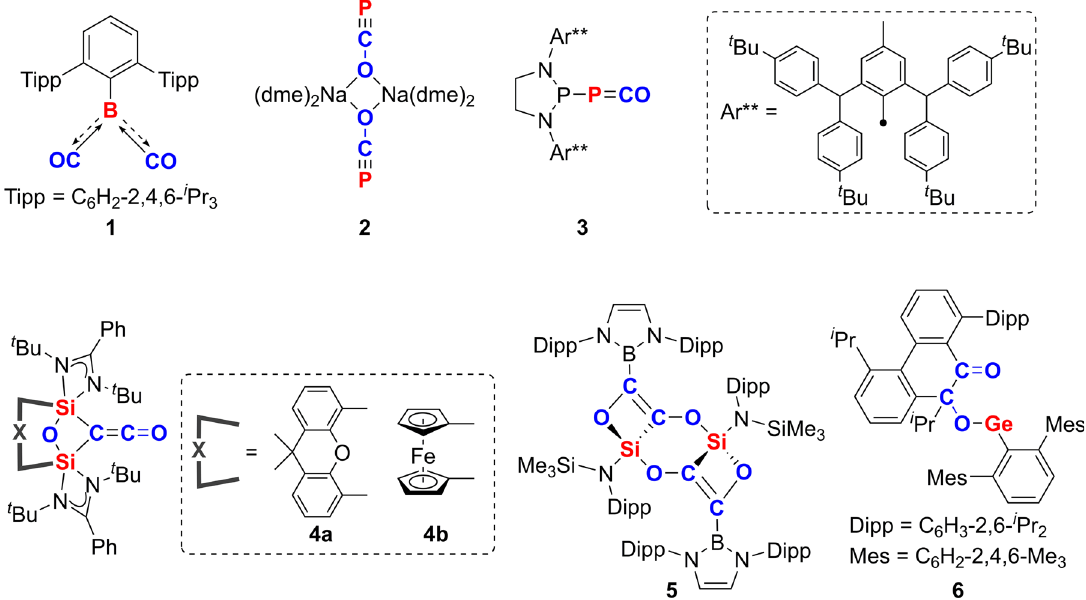
Fig. 1 Selected examples of main-group element compounds formed in the reactions with CO. Boron dicarbonyl complex ( 1 ) 5 , sodium phosphacyanate ( 2 ) 7 , phosphino-phosphaketene ( 3 ) 8 , and reductive homologation products ( 4 – 6 ) 11 – 13